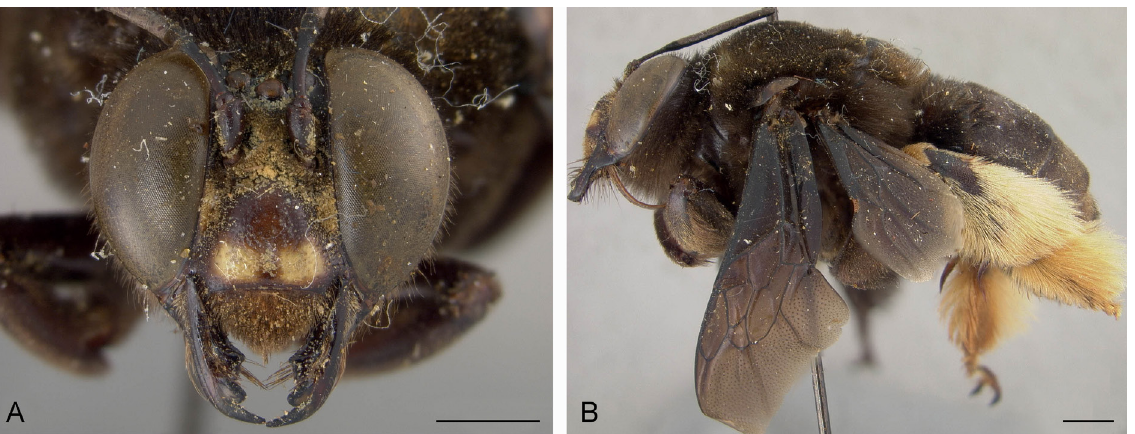
Centris fusciventris caurensis Cockerell, 1919: 189.